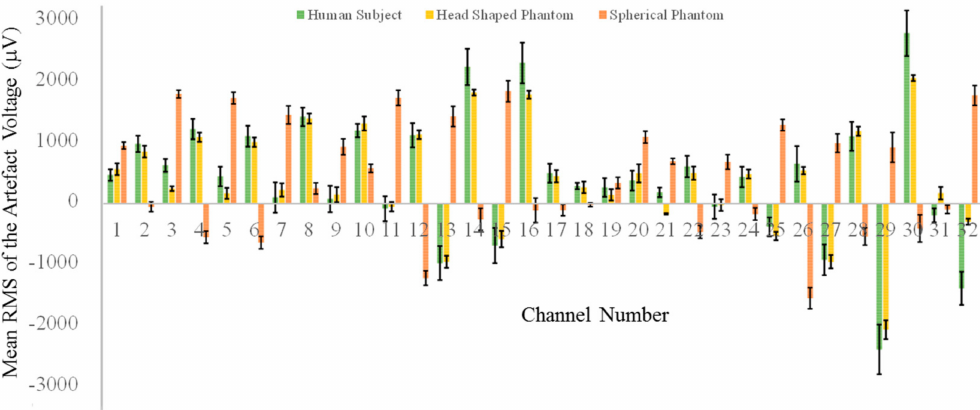
Figure 9. The average RMS of the induced GA recording for repeats of the AP orthogonal gradient for each channel on the subjects’ head, head-shaped phantom, and spherical phantom. Error bars show the corresponding standard deviation of the mean RMS over